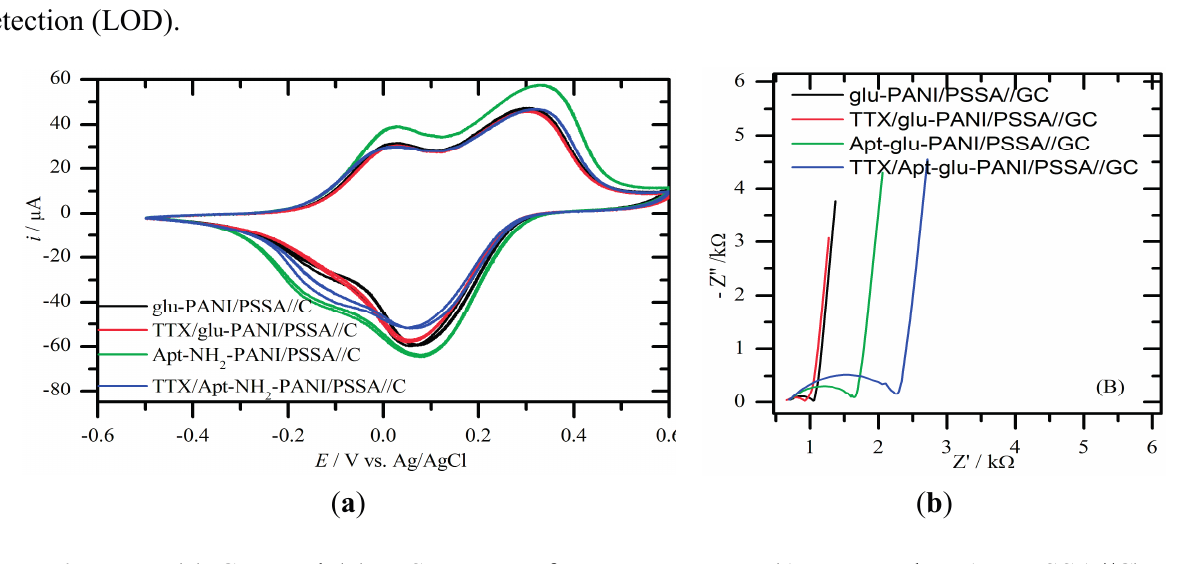
Figure 5. ( a ) CVs and ( b ) EIS spectra of TTX aptasensor (Apt-NH 2 -glu-PANI-PSSA//C) and the control sensor (glu-PANI/PSSA//C) before and after 30 min exposure to 5 μ M TTX standard solution in NaOAc buffer (0.1 M, pH